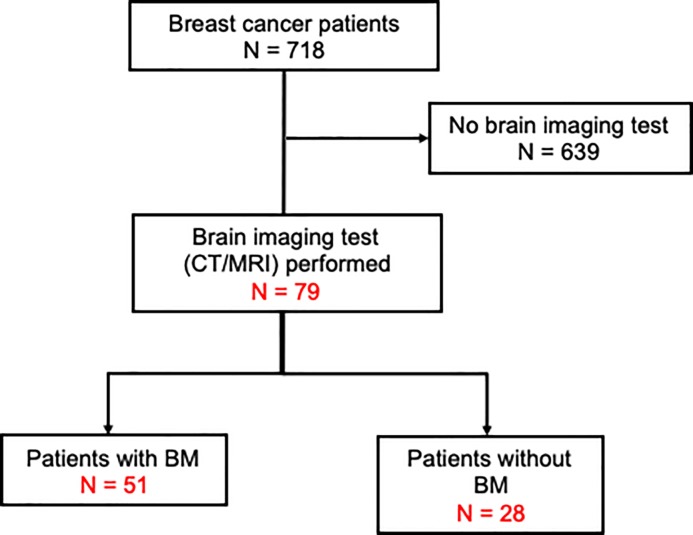
Consort diagram of the present study.CT/MRI, computed tomography/magnetic resonance imaging; BM, brain metastasis.